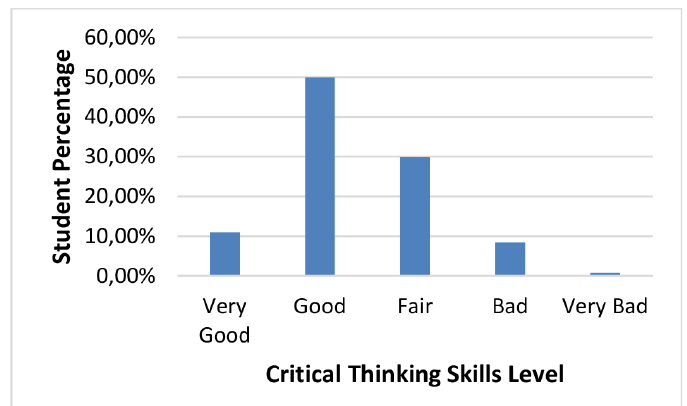
Figure 4. Histogram of Students’ Critical Thinking Skills Level